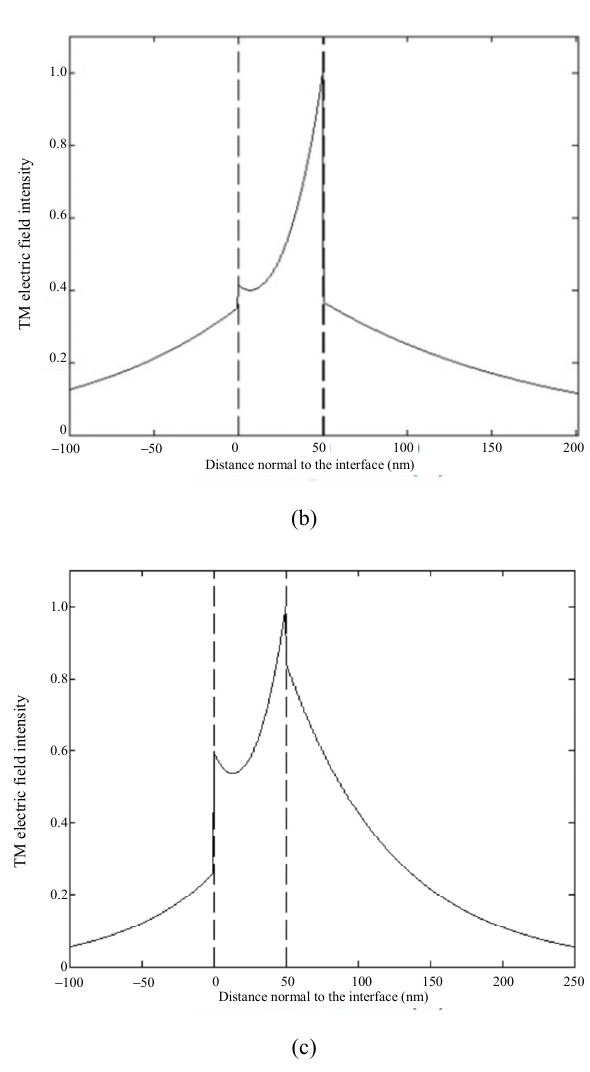
Fig. 6 Effect of increasing the number of blue P/MoS 2 hetero-structure layer on: (a) surface plasmon resonance curve and (b) sensitivity, detection accuracy, and quality factor.